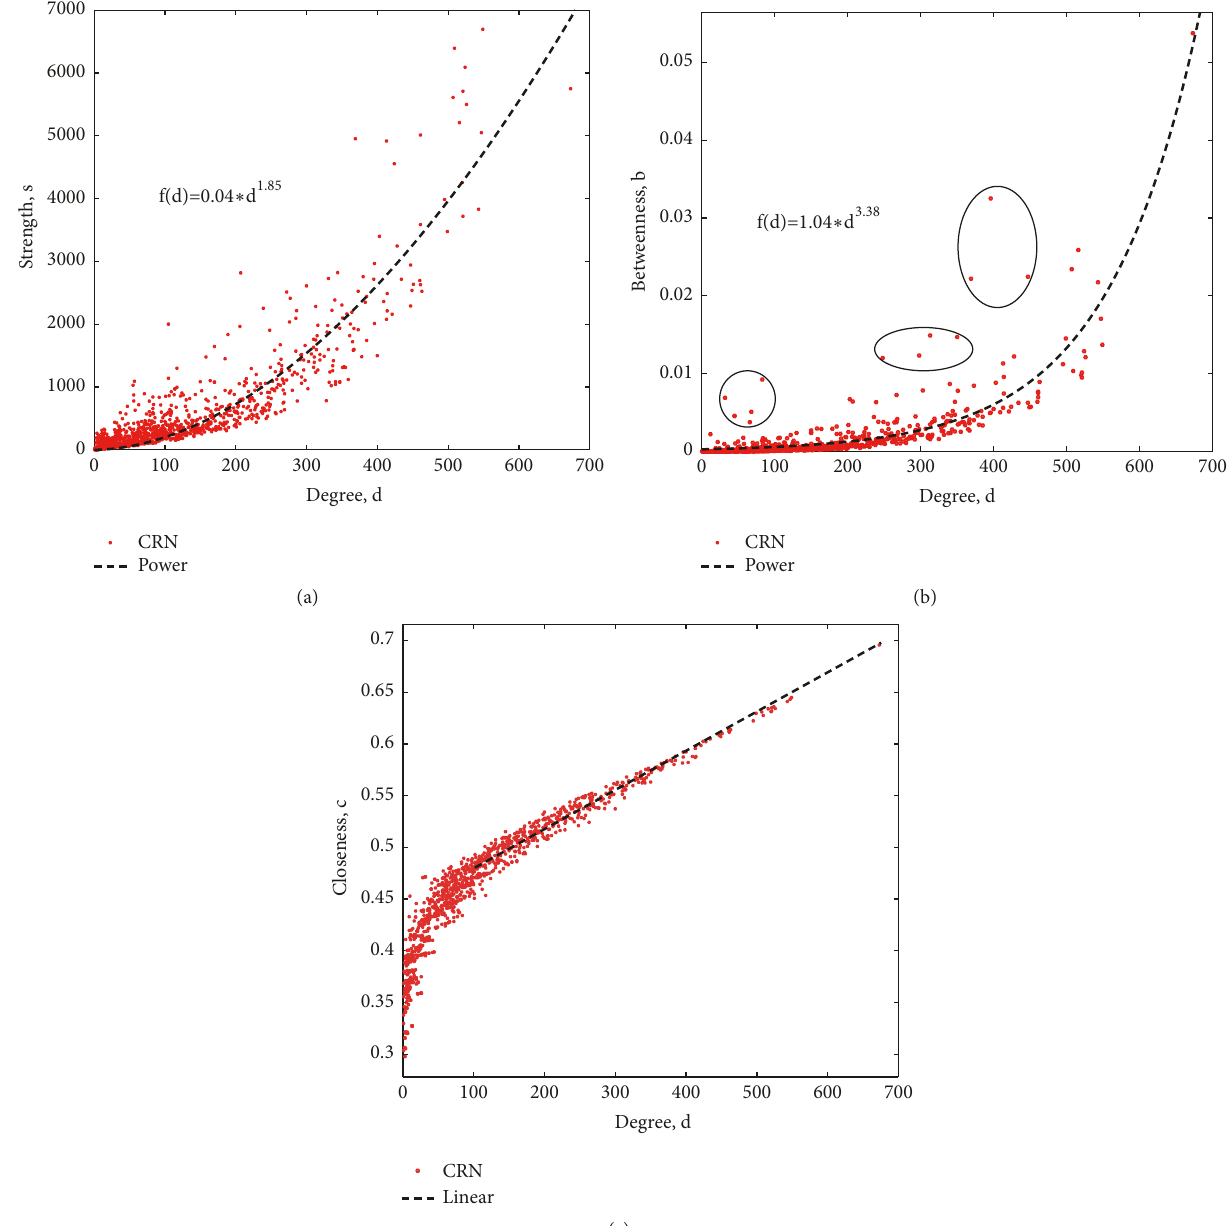
Figure 6: (a) The relationship between nodal degree and strength in CRN. (b) The relationship between nodal degree and betweenness in CRN. (c) The relationship between nodal degree and closeness in